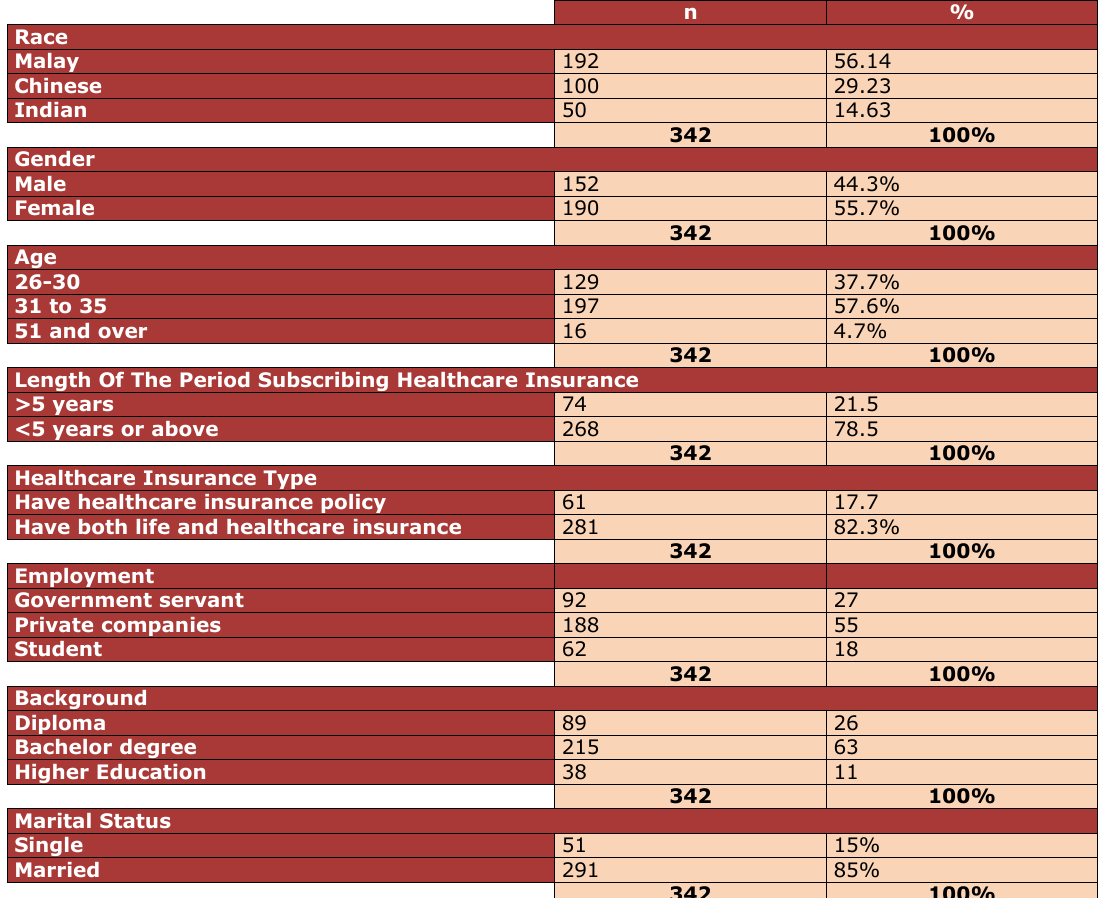
Table 1. Descriptive statistics of demographic